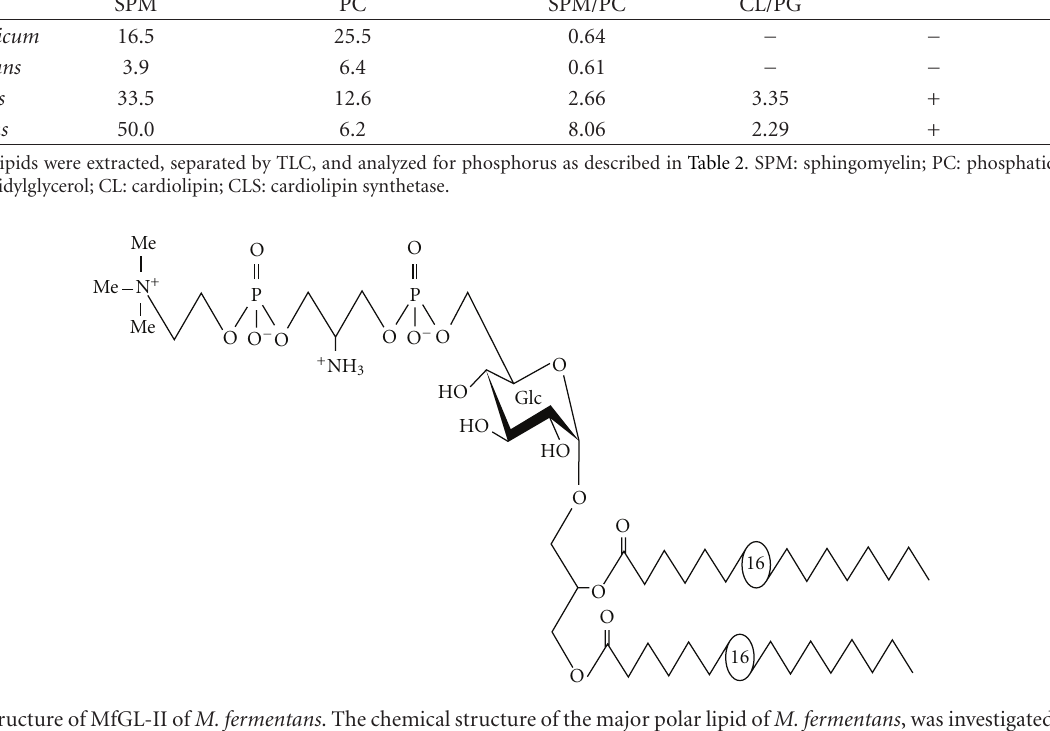
Table 3: De novo synthesized phospholipids and phospholipids incorporated from the growth medium in representative Mycoplasma species. Organisms